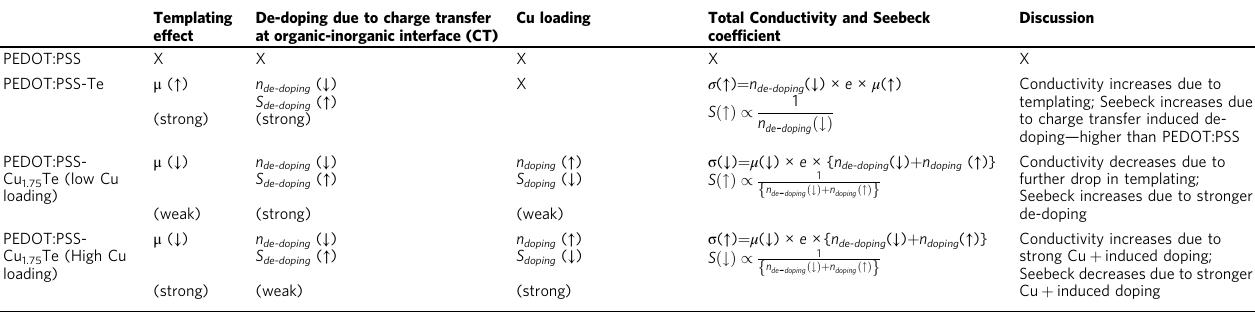
Table 2 Summary of physical phenomena contributing to thermoelectric